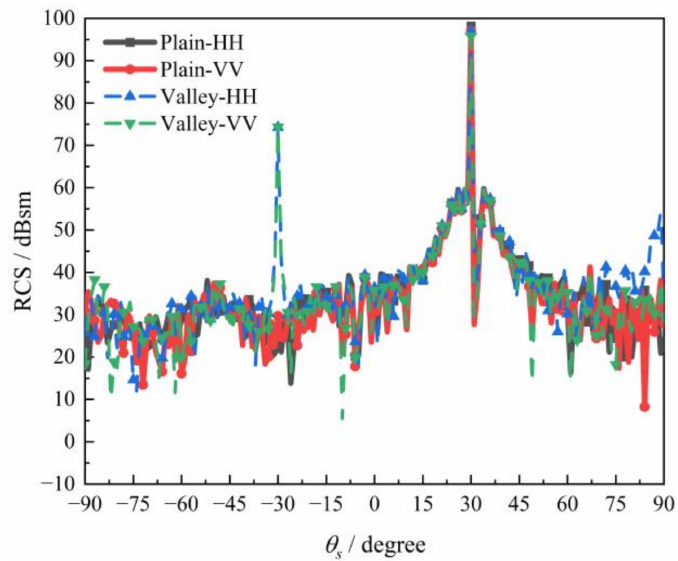
Figure 11. Bistatic RCS results for a missile-like target above plain and valley composite rough